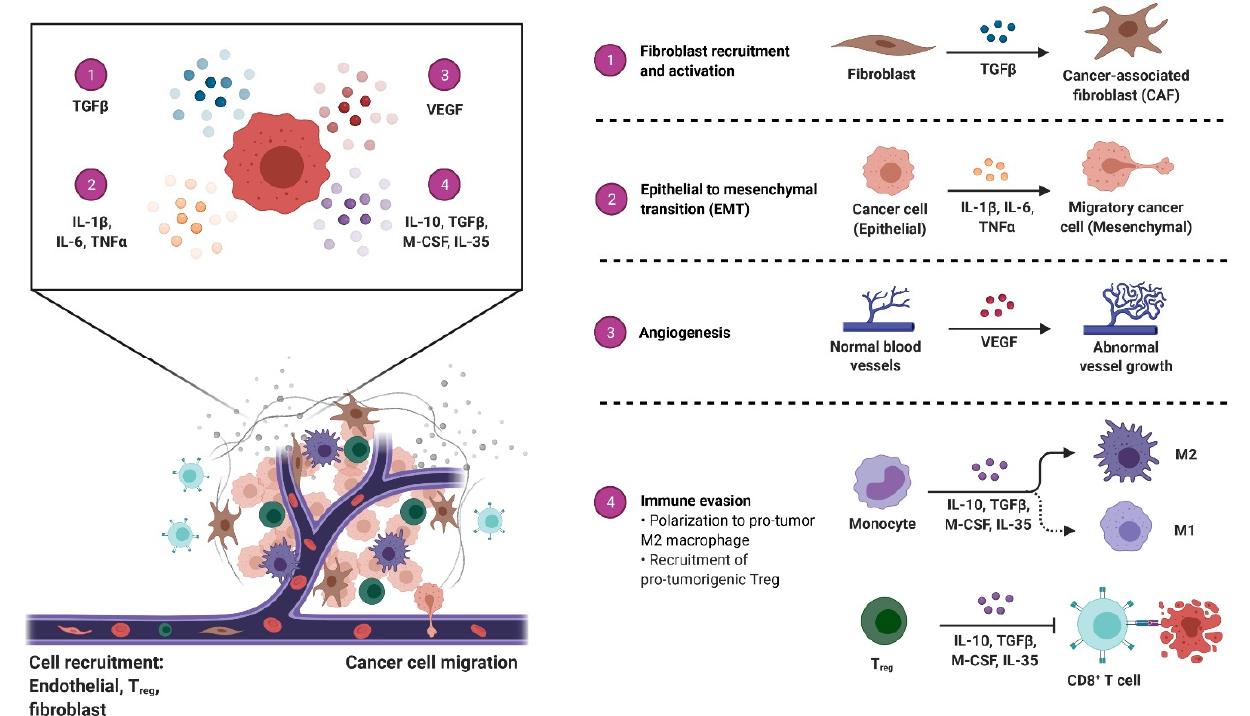
Figure 4. The tumor microenvironment: overview of cancer-associated changes. The tumor microenvironment (TME) includes the cellular components surrounding the tumor mass, such as immune cells, fibroblasts, and epithelial cells, and the acellular components, including the extracellular matrix and blood vessels. Cancer cells release molecules that modulate the TME and contribute to cancer growth through immune evasion, metastatic niche formation, and neoangiogenesis, among other functions that contribute to the hallmarks of cancer. This image was created using BioRender (http://biorender.com/ accessed on 10 August 2021).